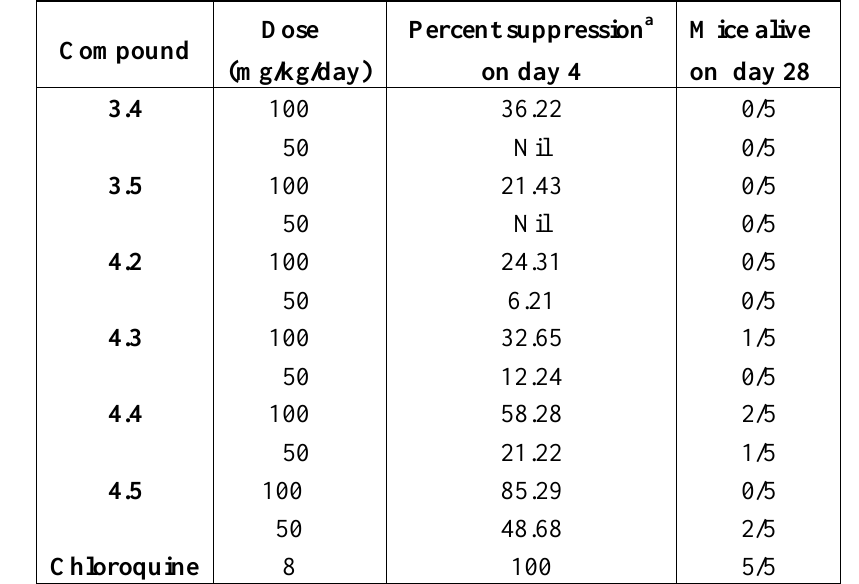
Table 2 . In vivo antimalarial activity against P. berghei in